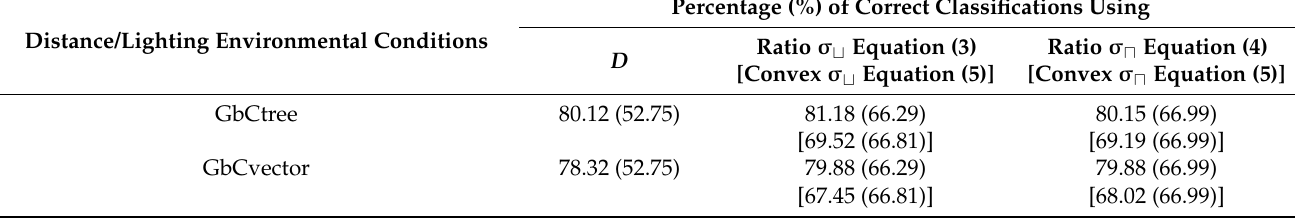
Table 8. Results by GbC classifiers both optimized and non-optimized (within parentheses) for sigmoid positive valuation function regarding facial expression recognition.